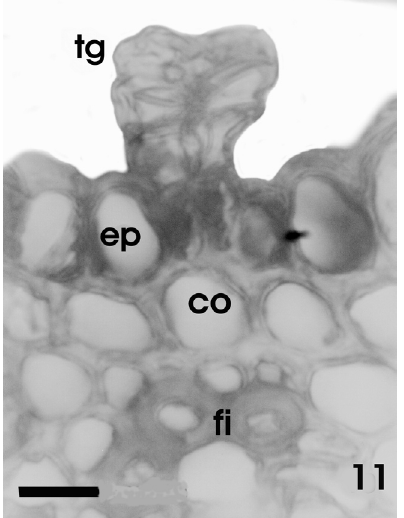
FIGURA 11 – B. microcephala – Detalhe do eixo caulinar, em secção transversal. co: colênquima; ep: epiderme; fi: fibras esclerenquimáticas; tg: tricoma glandular bisseriado. Barra = 10 µ m.